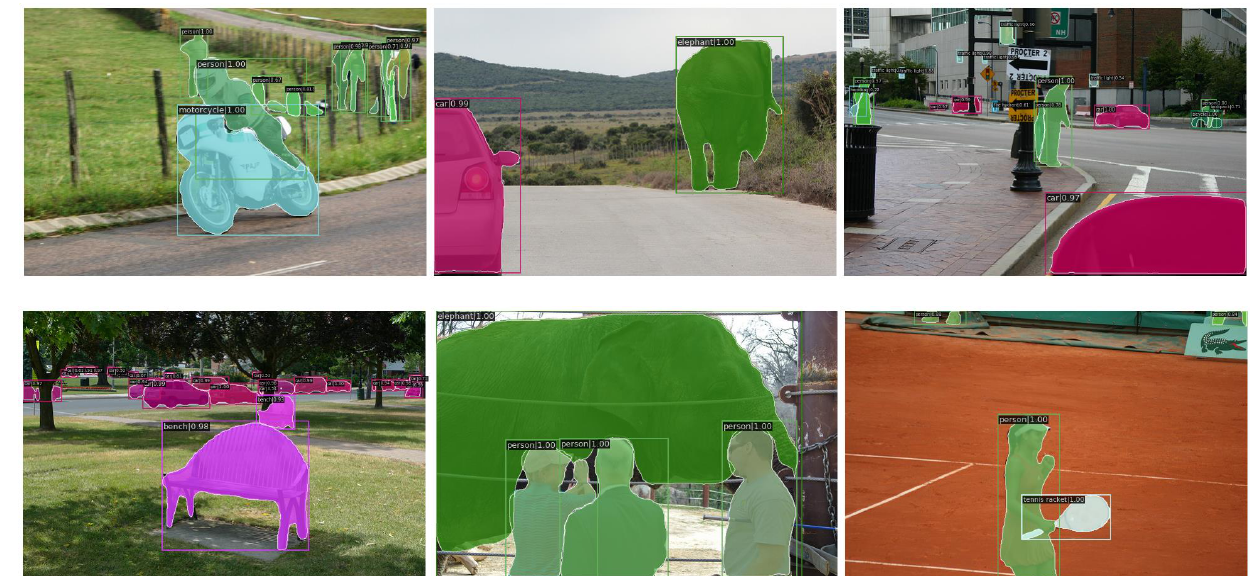
Figure A1. Examples of our PLG-ViT with Mask RCNN [56] on COCO [22].